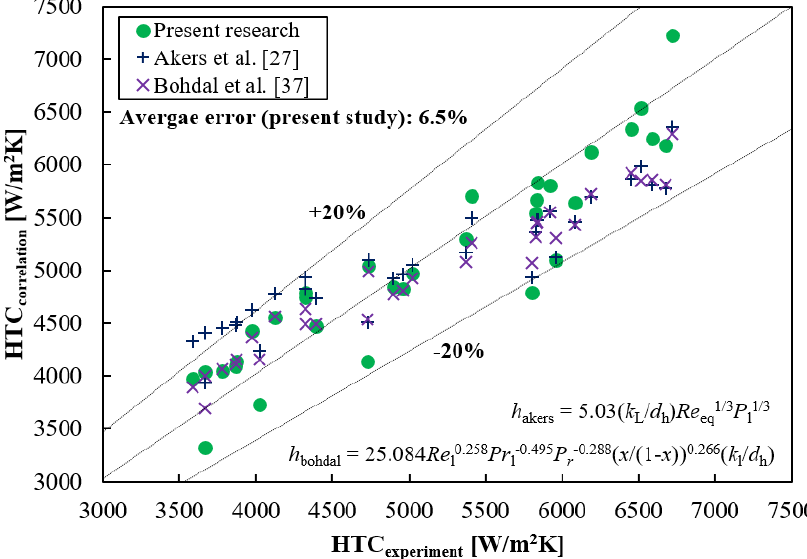
Figure 12. Comparison between experimental and calculated 2-stream condensation HTC.